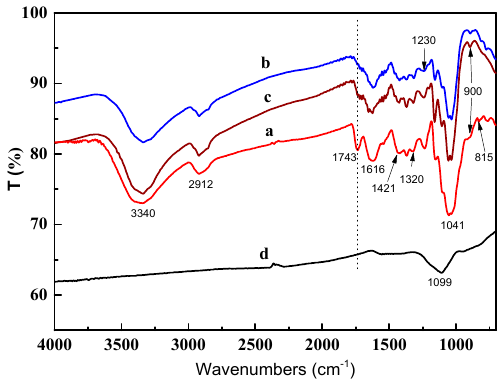
Figure 2. Fourier-transform infrared spectroscopy (FT-IR) of eggplant gels. ( a ) E c ; ( b ) EH 1 ; ( c ) EH 2 ; ( d ) CA 1 .